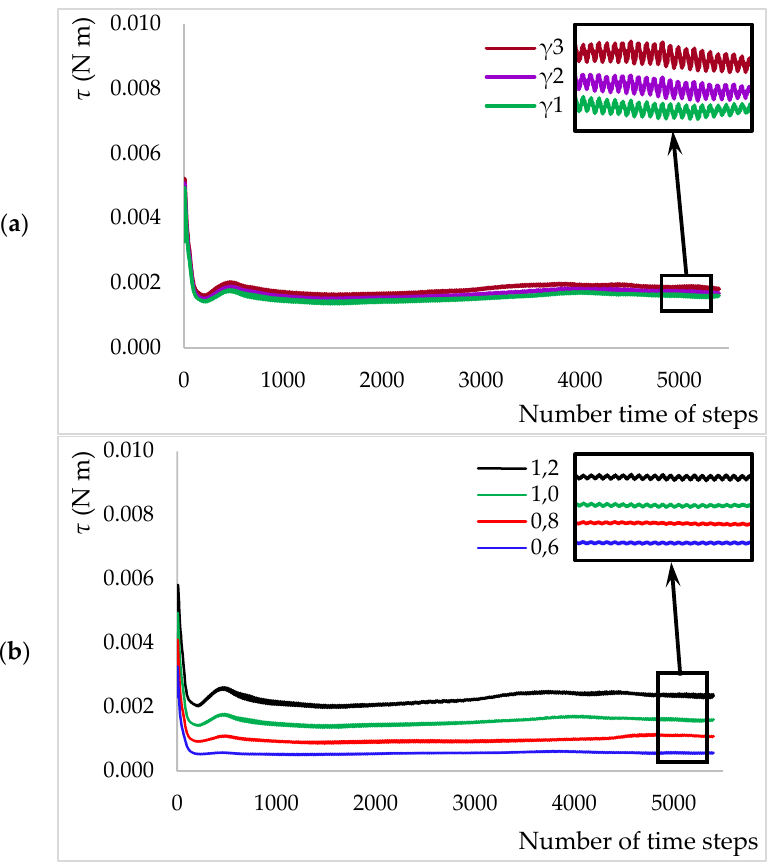
Figure 3. Torque and time-step dependency for three mass concentrations of zeolite suspension ( a ) and N / N JS ratios ( b ). The relationships between the power consumption per unit mass at N JS for different zeolite suspension mass concentrations or different N / N JS ratios, respectively, are pre- sented in Figure 4.